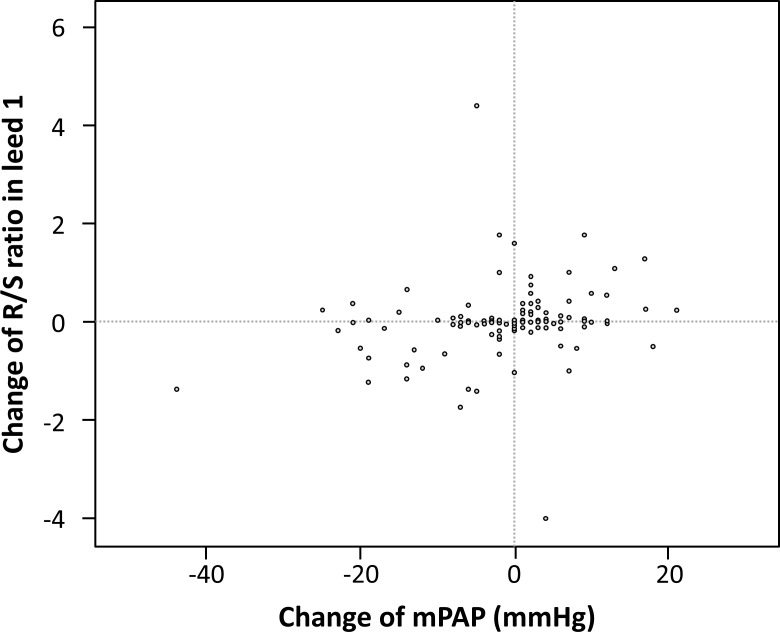
Association between changes in the electrical axis and changes in mean pulmonary arterial pressure in patients where two right heart catheterizations were performed at different time points.(mPAP: mean pulmonary arterial pressure).